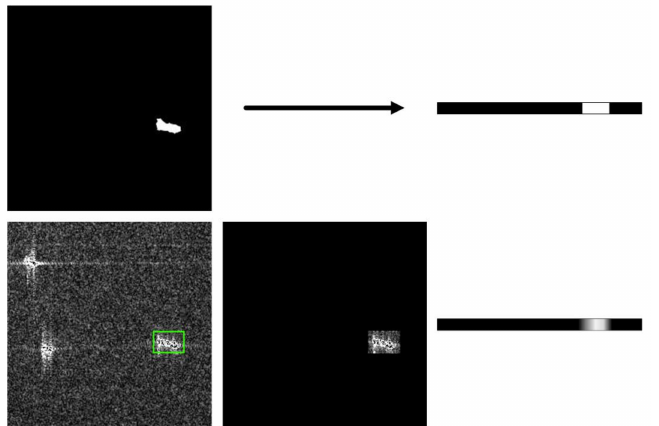
Figure 6. Flatten process in two branches. The top row is the flatten process of the mask in the pixel branch. The bottom row is the flatten process of the result in the object branch. All parts of the original image beyond box are set to zero. Then, each column is maximized to produce a